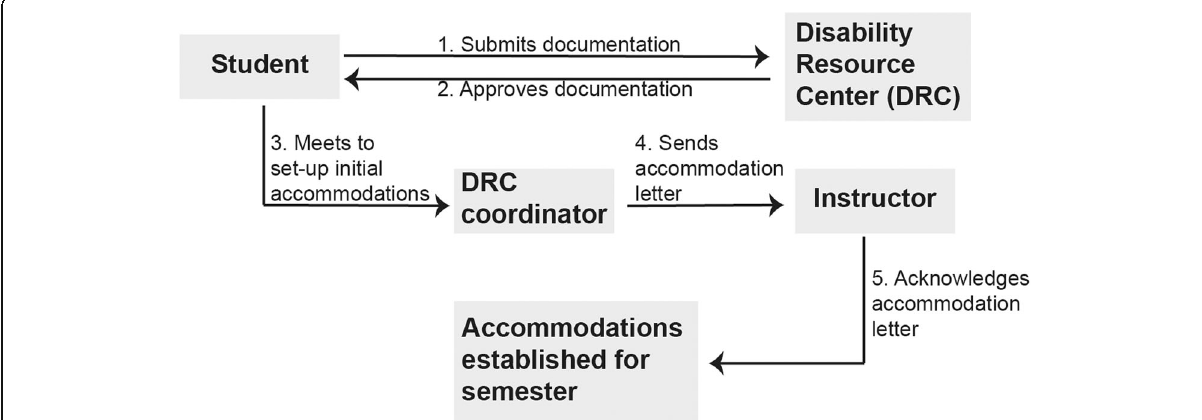
Fig. 3 Overview of the accommodation process our participants experienced to initially establish and use accommodations in undergraduate STEM courses. (1) Students with qualifying disabilities submit official documentation to the campus Disability Resource Center (DRC). (2) The DRC reviews and approves the documentation, and subsequently (3) the student can schedule an initial accommodation meeting with their assigned DRC coordinator. During this initial meeting, the student and their DRC coordinator agree on the accommodations the student will request